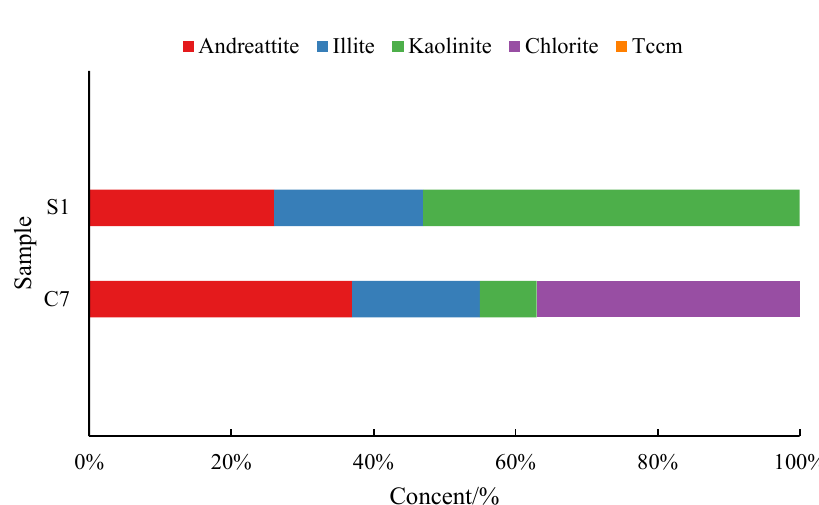
221 Figure 4. Phase diagram of CO 2.